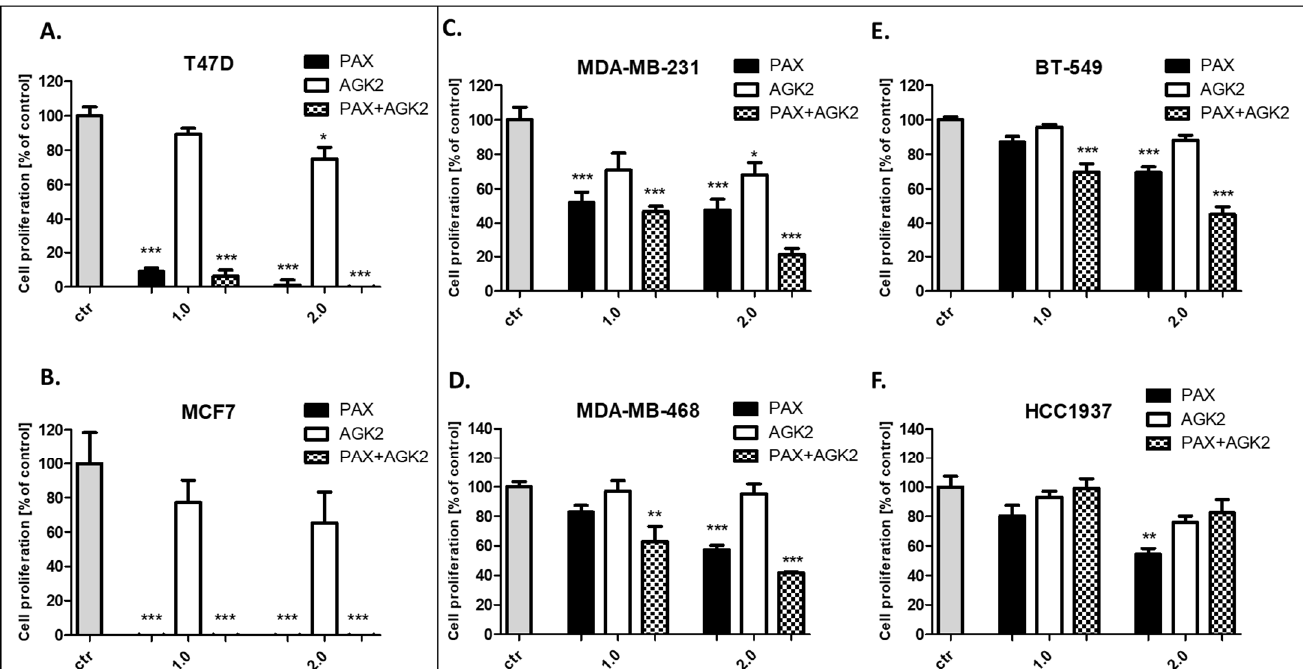
Figure 9 . Effect of AGK2 and paclitaxel (PAX) alone or AGK2 in combination with PAX on the ( A ) T47D, ( B ) MCF7, ( C ) MDA-MB-231, ( D ) MDA-MB-468, ( E ) BT-549 and ( F ) HCC1937 BC cells in the